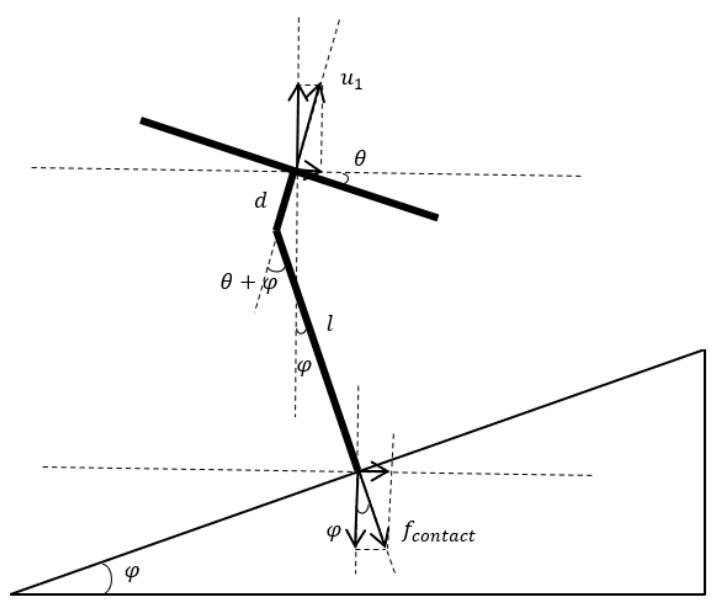
Figure 2. The analysis of contact force.